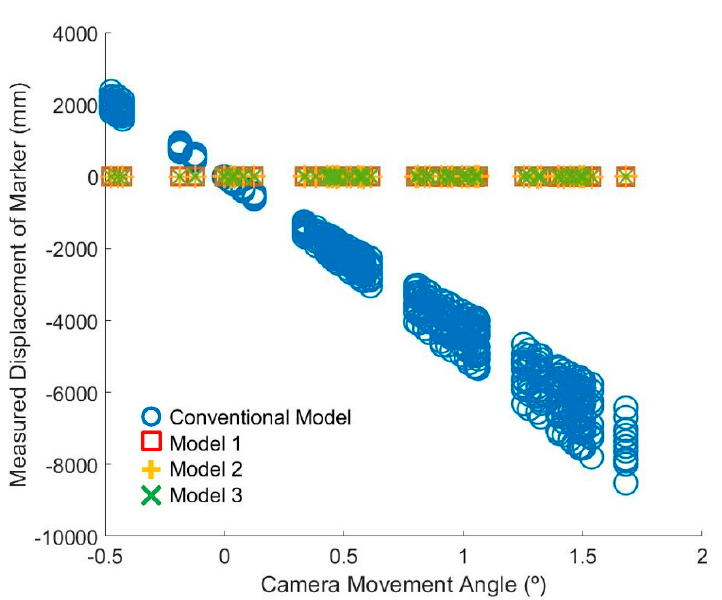
Figure 9. Measured displacement of fixed markers by model vs. camera movement angle.